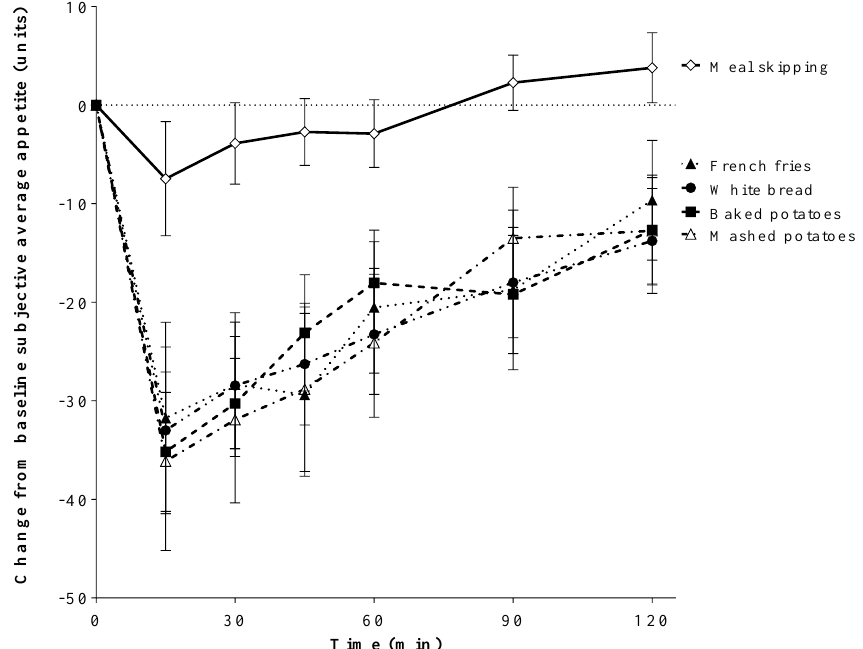
Figure 1. Effect of treatment on change from baseline average appetite scores (units) over 120 min (two-factor ANOVA, Tukey-Kramer’s post hoc test). All values are means ± SEM, n = 20. Change from baseline subjective appetite was affected by treatment ( p < 0.001), time ( p < 0.001), and treatment by time interaction ( p < 0.001). Change from baseline subjective appetite was lower after all caloric test treatments compared with meal skipping ( p < 0.001), but did not differ from each other.